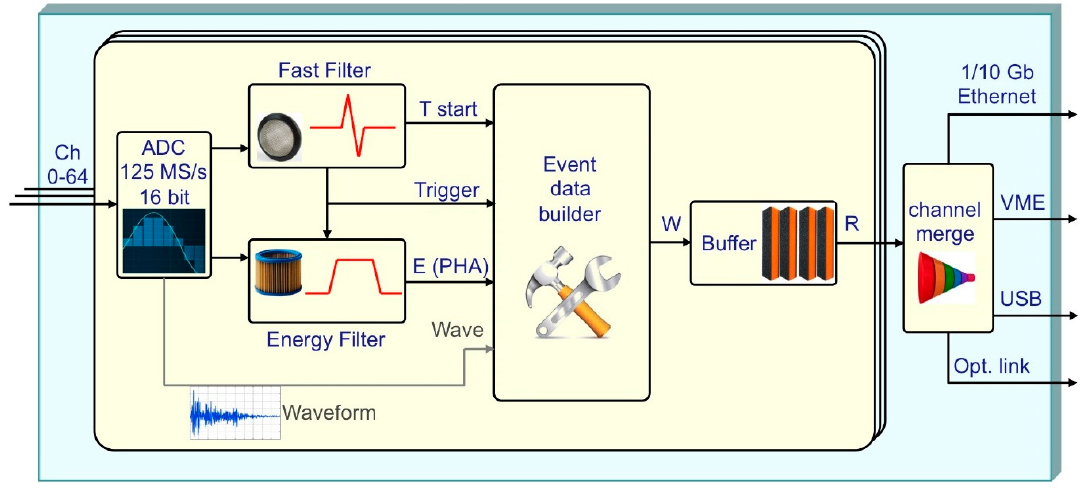
Figure 16. Block scheme of the VX2740 digitizer operational features.